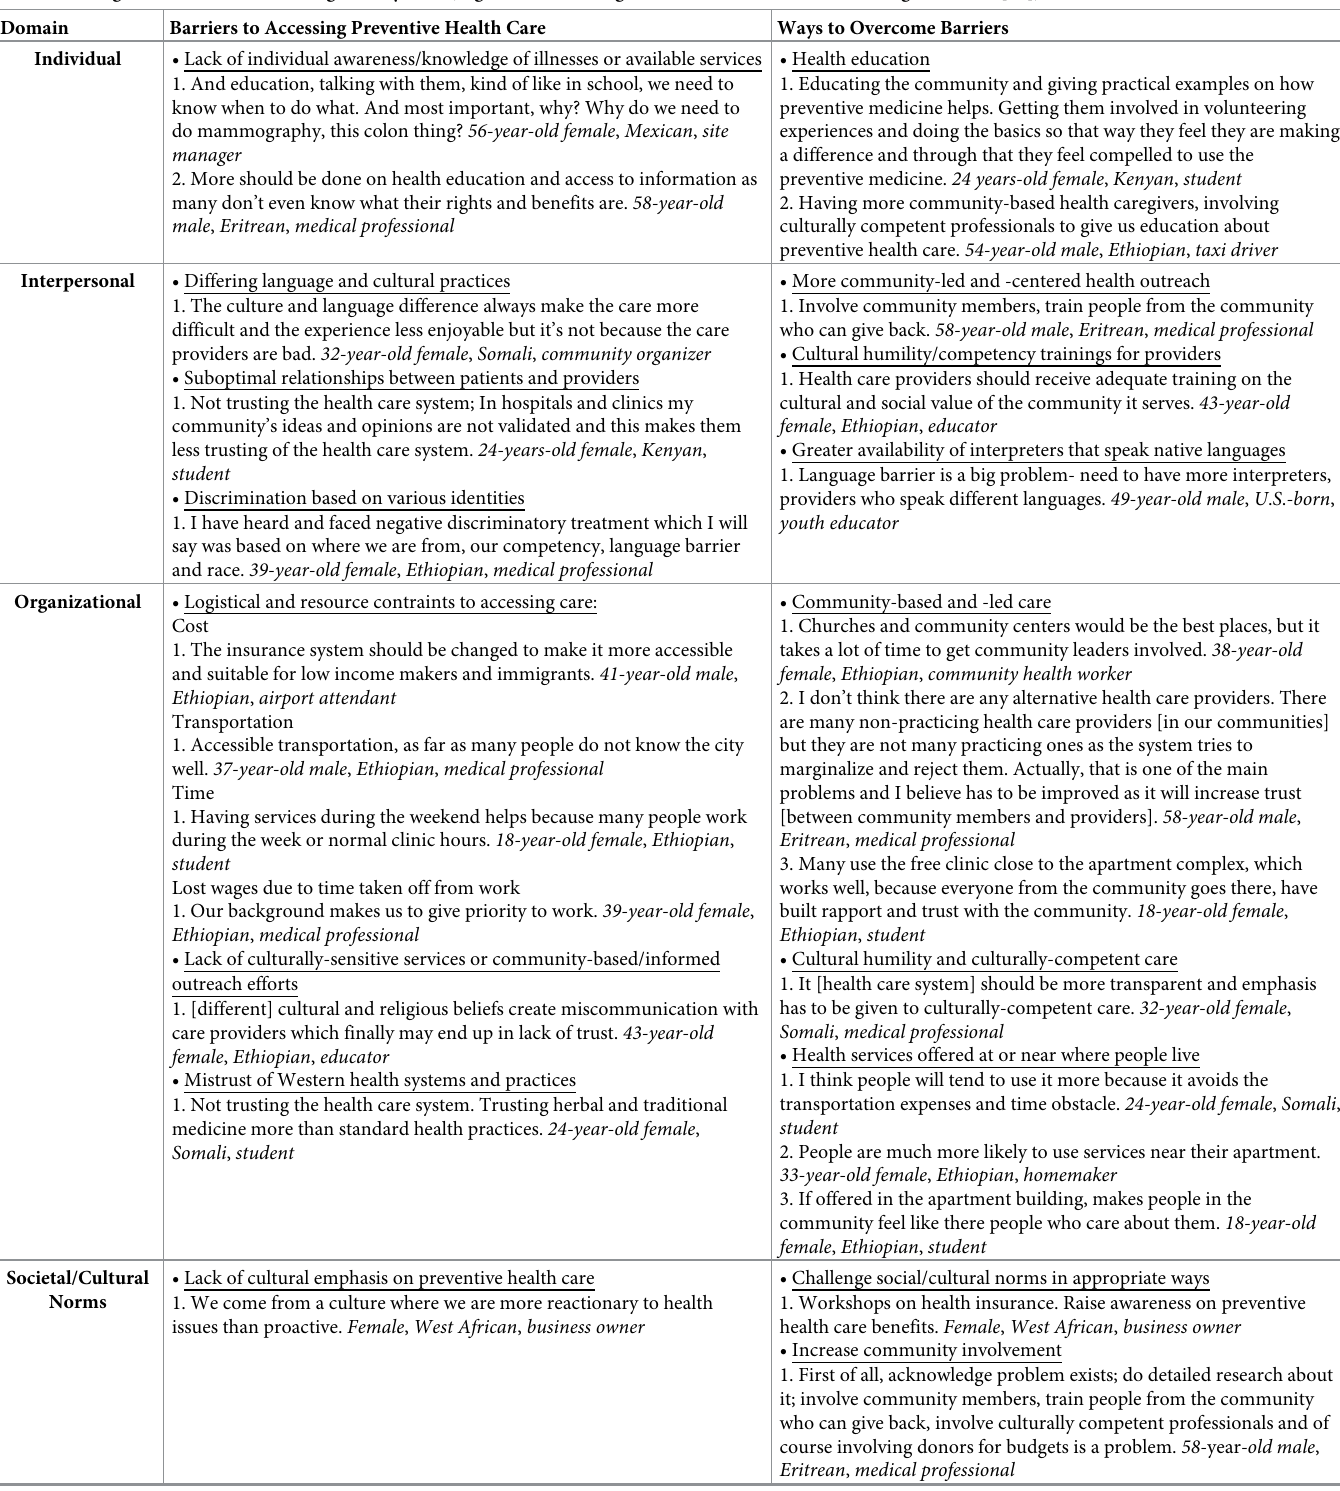
Table 2. Indirect quotes from key informant interviews describing barriers to accessing preventive health care, as well as the ways to help overcome them, among African immigrant communities in King County, WA (organized according to the domains in the socio-ecological model [37]).